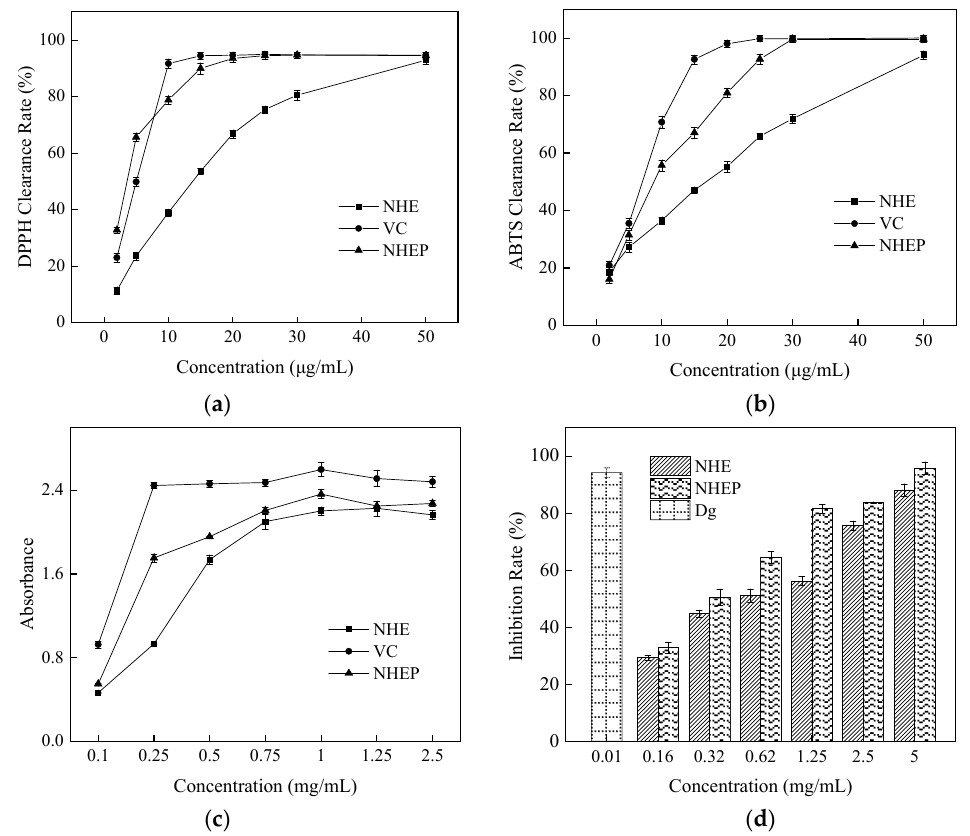
Figure 5. Activities of the NHE, NHEP and positive control by chemical method. ( a ) DPPH, ( b ) ABTS, ( c ) Reduction power, ( d ) Hyaluronidase inhibition assay. Dg stands for Dipotassium glycyrrhizinate, and the concentration is 10 μ g/mL. The date is shown as the mean ± S.D. ( n = 3).